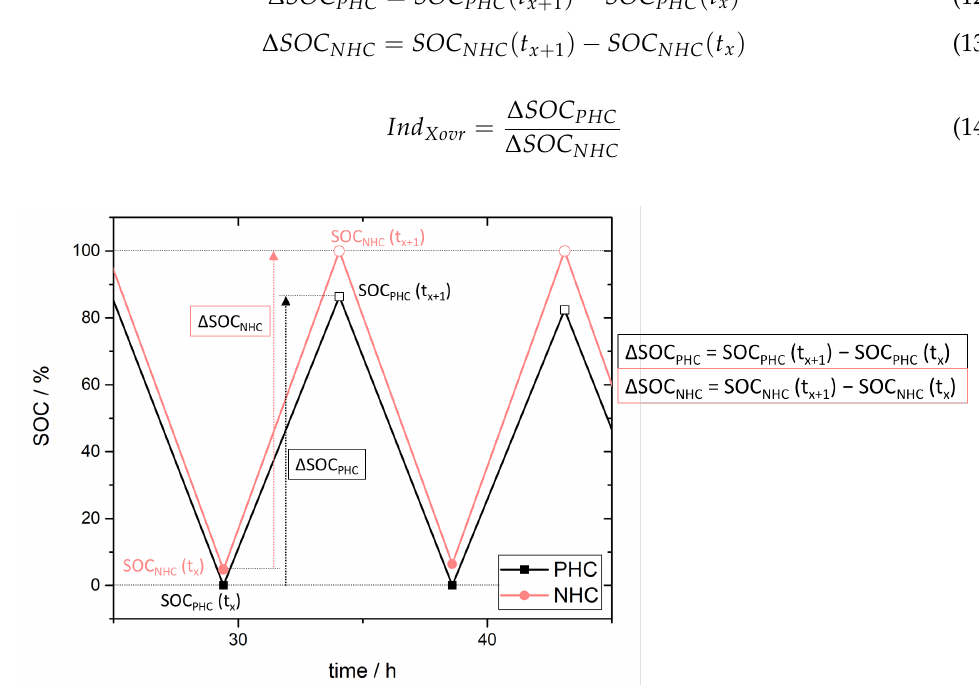
Figure 3. Scheme for the determination of crossover index Ind Xovr from state of charge (SOC) in the positive half-cell (PHC) and negative half-cell